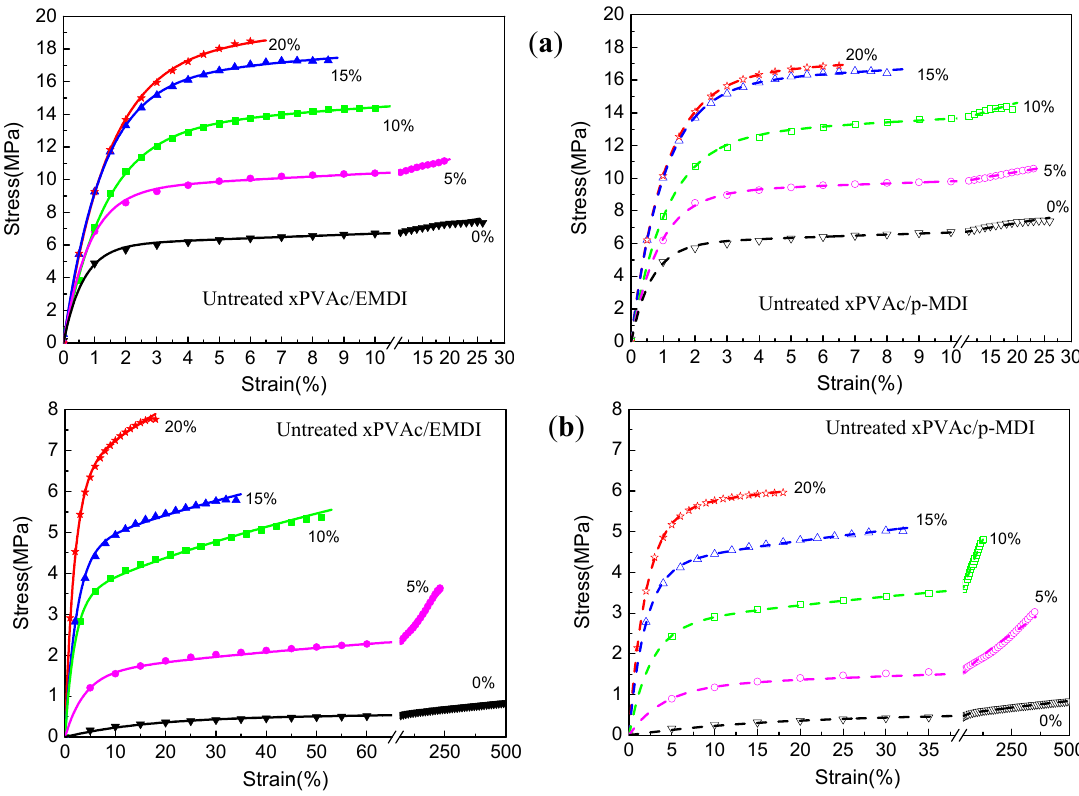
Figure 1. Effect of cross-linker on the tensile curves of cured EPI films at ( a ) 0% RH and ( b ) 80% RH (dot: experimental data, solid line: calculated by Equation (2)).